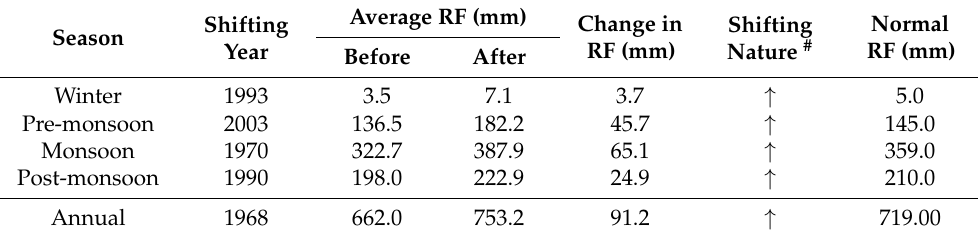
Table 6. The shifting pattern of seasonal rainfall (mm) data of